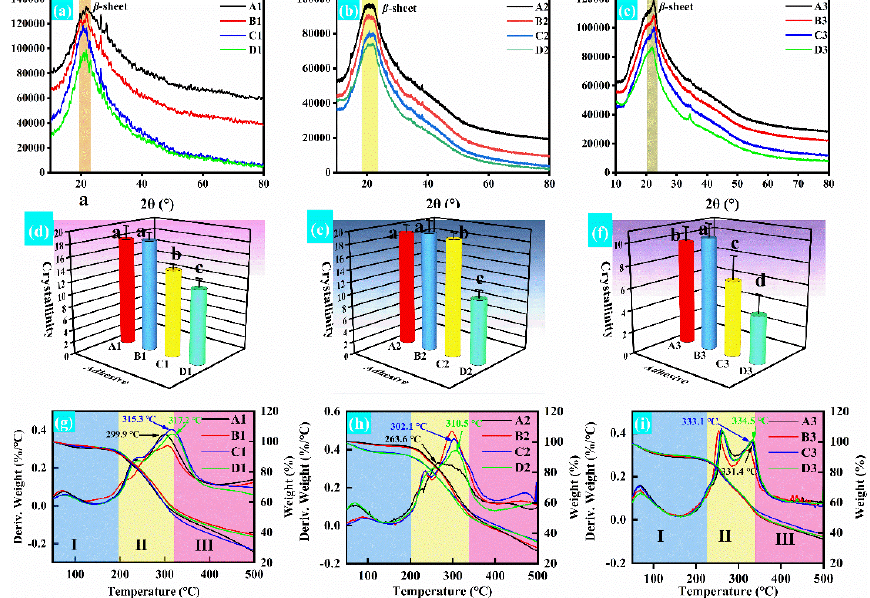
Figure 6. ( a – c ) XRD profiles, ( d – f ) crystallinity, ( g – i ) thermal degradation curves of A1 ‐ pure